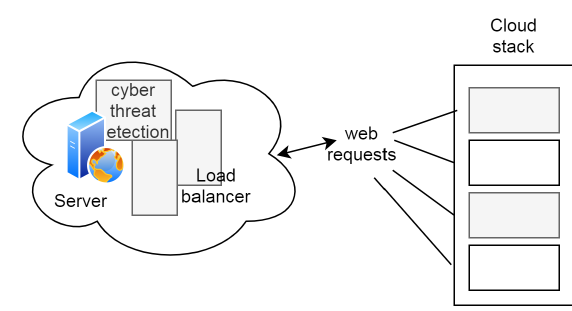
Figure 5. Testbed for cyber security threat simulation. Table 5. Result